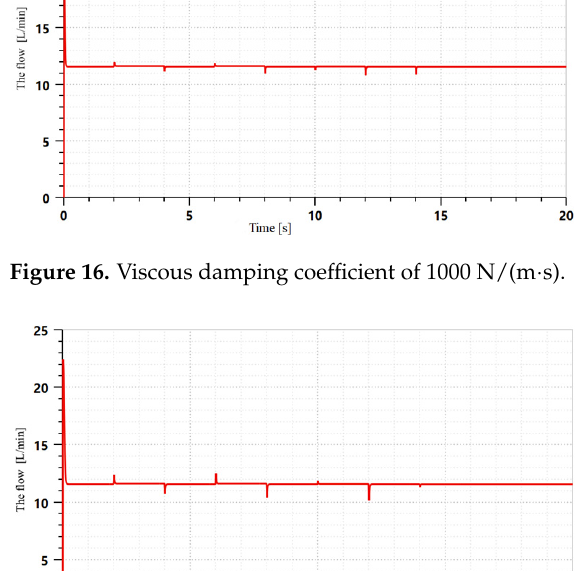
Figure 17. Viscous damping coefficient of 2000 N/(m·s).